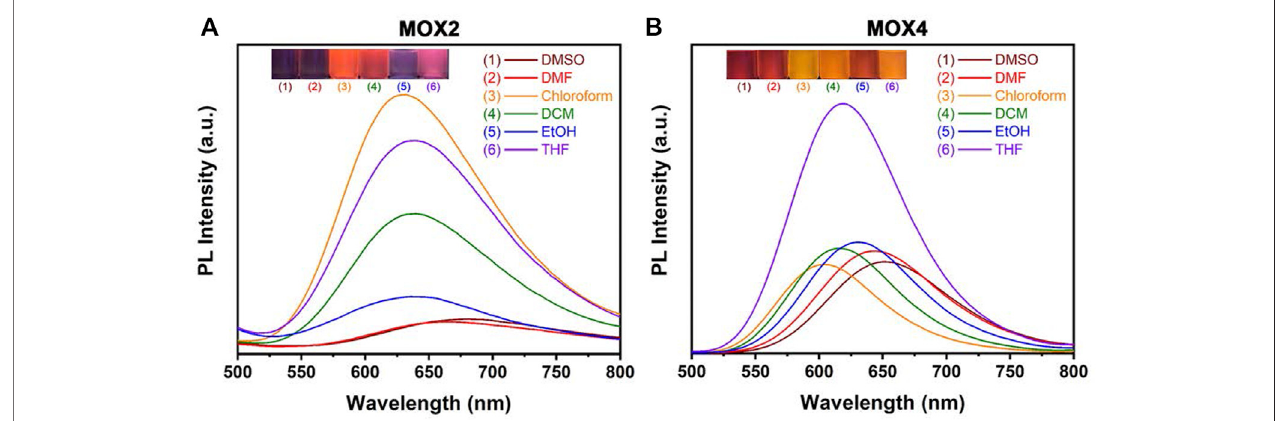
FIGURE 3 | PL spectra of compounds MOX2 (A) and MOX4 (B) in various solvents (50 µM), such as DMSO, DMF, chloroform, DCM, EtOH, THF, respectively. Inset: photograph of MOX2 (A) and MOX4 (B) in various solvents with UV irradiation ( λ (cid:1) 365 nm).